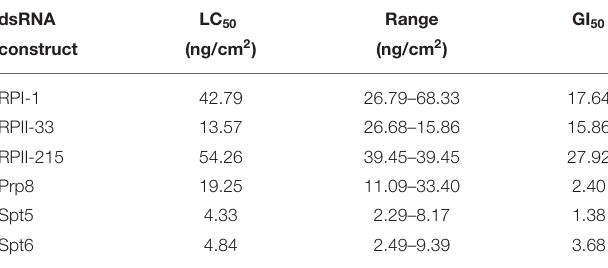
TABLE 2 | LC50 and GI50 for RPI-1, RPII-33, RPII-215, Prp8, Spt5, and Spt6 in larval D. v. virgifera diet-based bioassay 9 dpf. dsRNA LC 50 Range GI